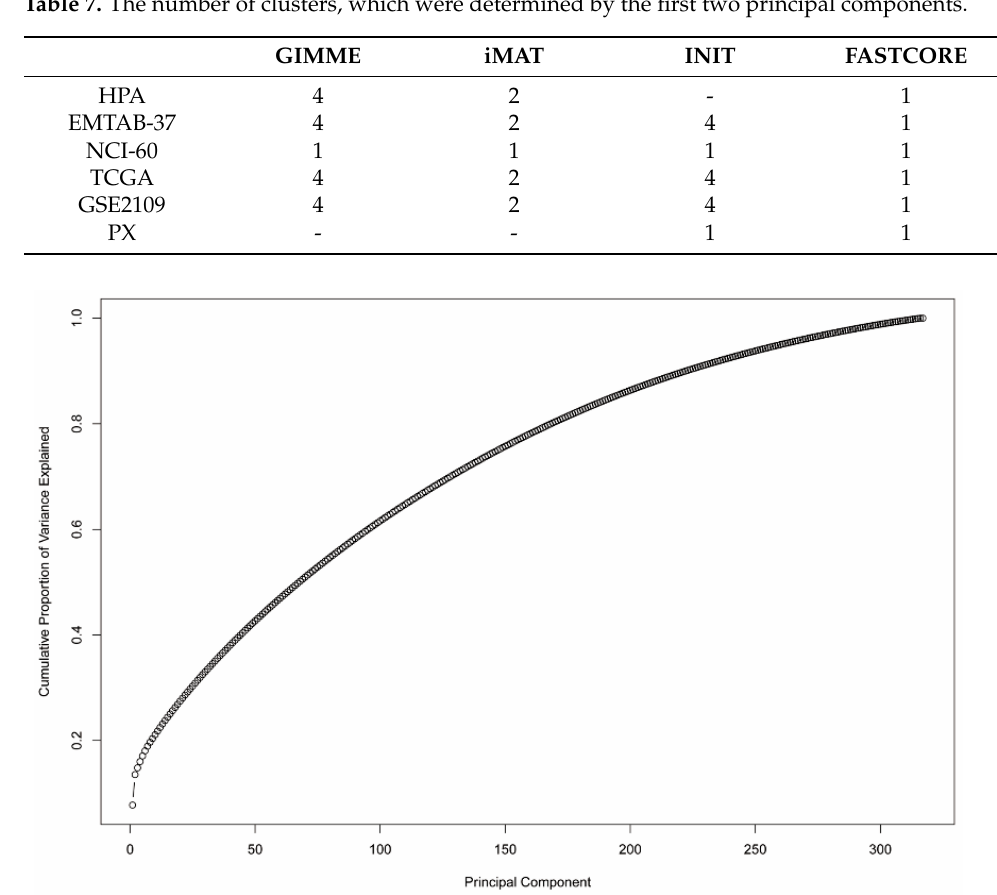
Figure 6. The cumulative variance plot of PCA analysis for EMTAB-37 dataset and GIMME method.